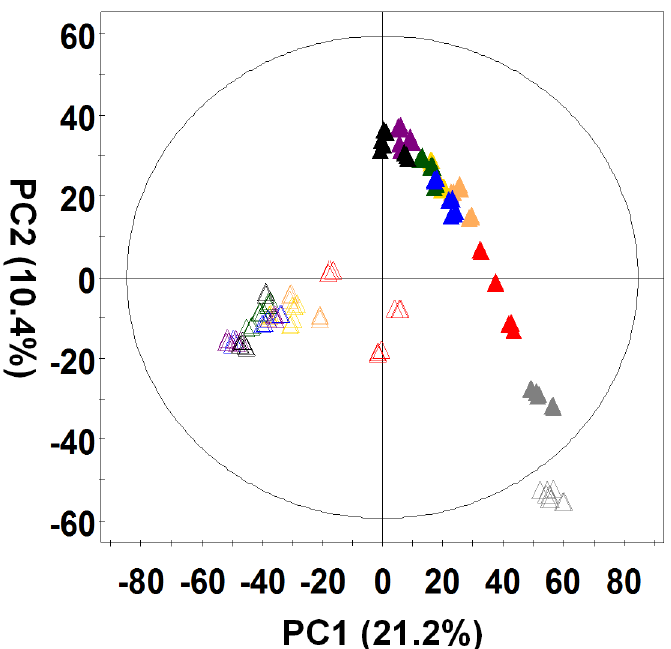
Fig 1. Principal component analysis (PCA) score plot derived from the UPLC-Q-TOF-MS dataset of P . expansum 40815 during fermentation. ( 4 : Submerged fermentation, ▲ : Solid-state fermentation, gray: 0 days, red: 4 days, orange: 6 days, yellow: 8 days, green: 10 days, blue: 12 days, violet: 14 days, black: 16 days)